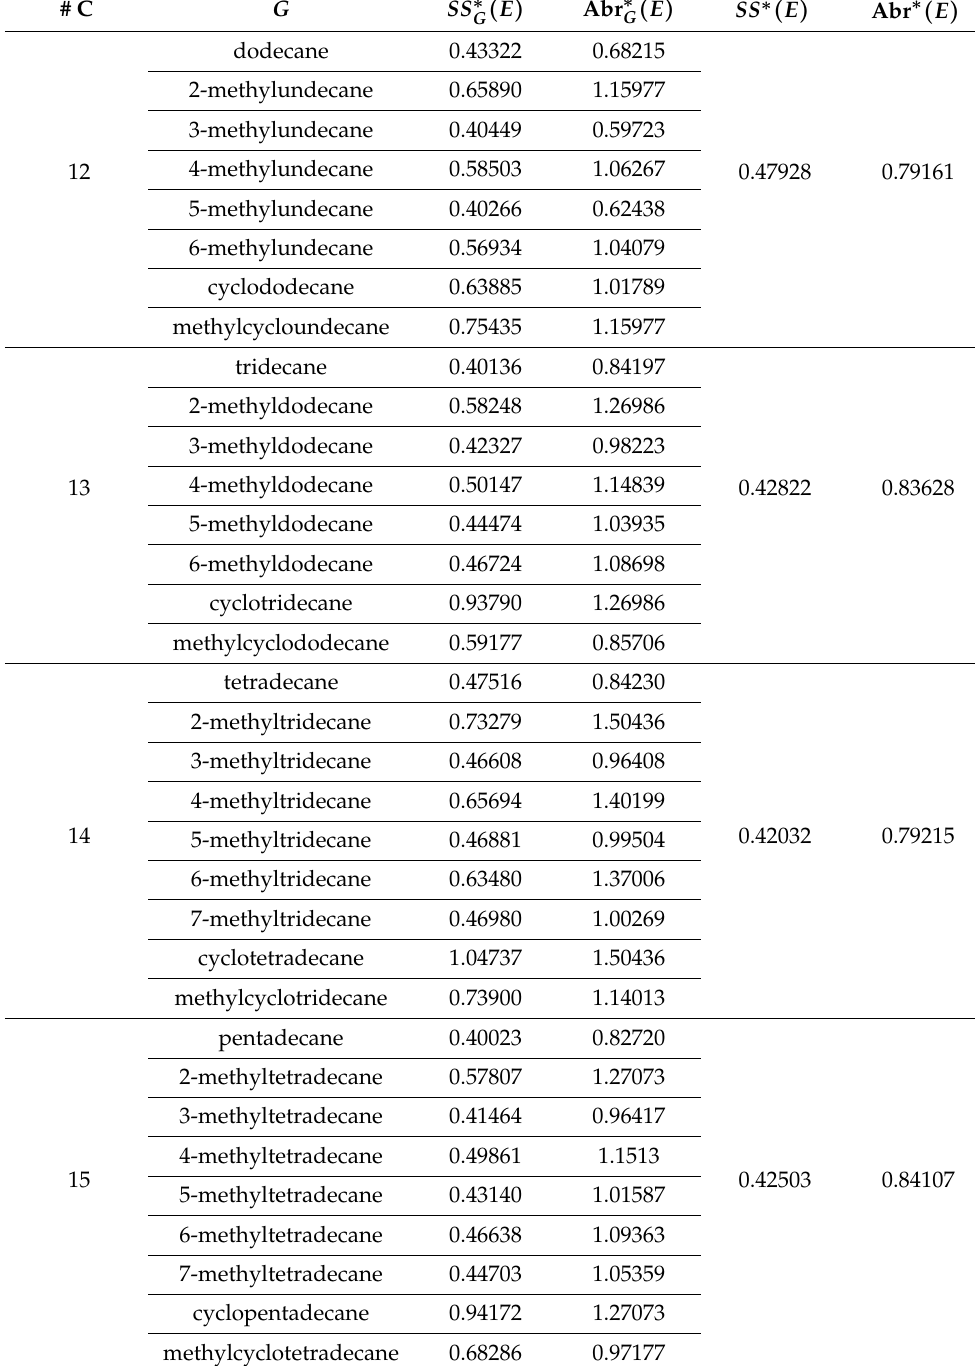
Table A3. Modified structure sensitivity and modified abruptness with average values, Part